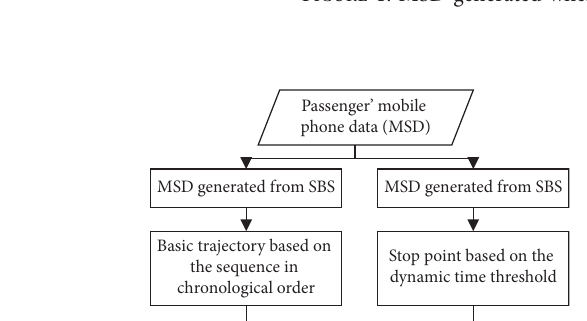
Figure 1: MSD generated when entering or leaving subway station.